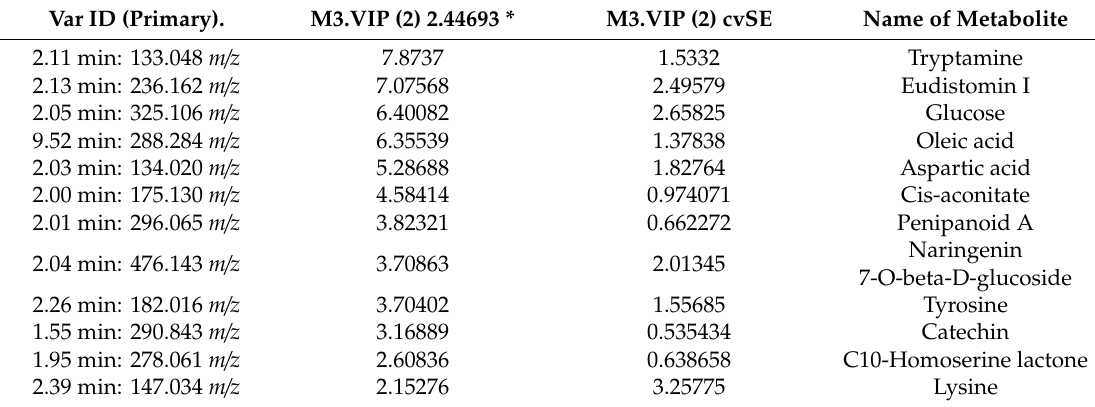
Table 2. Putatively identified metabolites with the highest score of the Variable Influence on Projection (VIP) as determined by a Partial Least Square-Discriminant Analysis (PLS-DA). Var ID